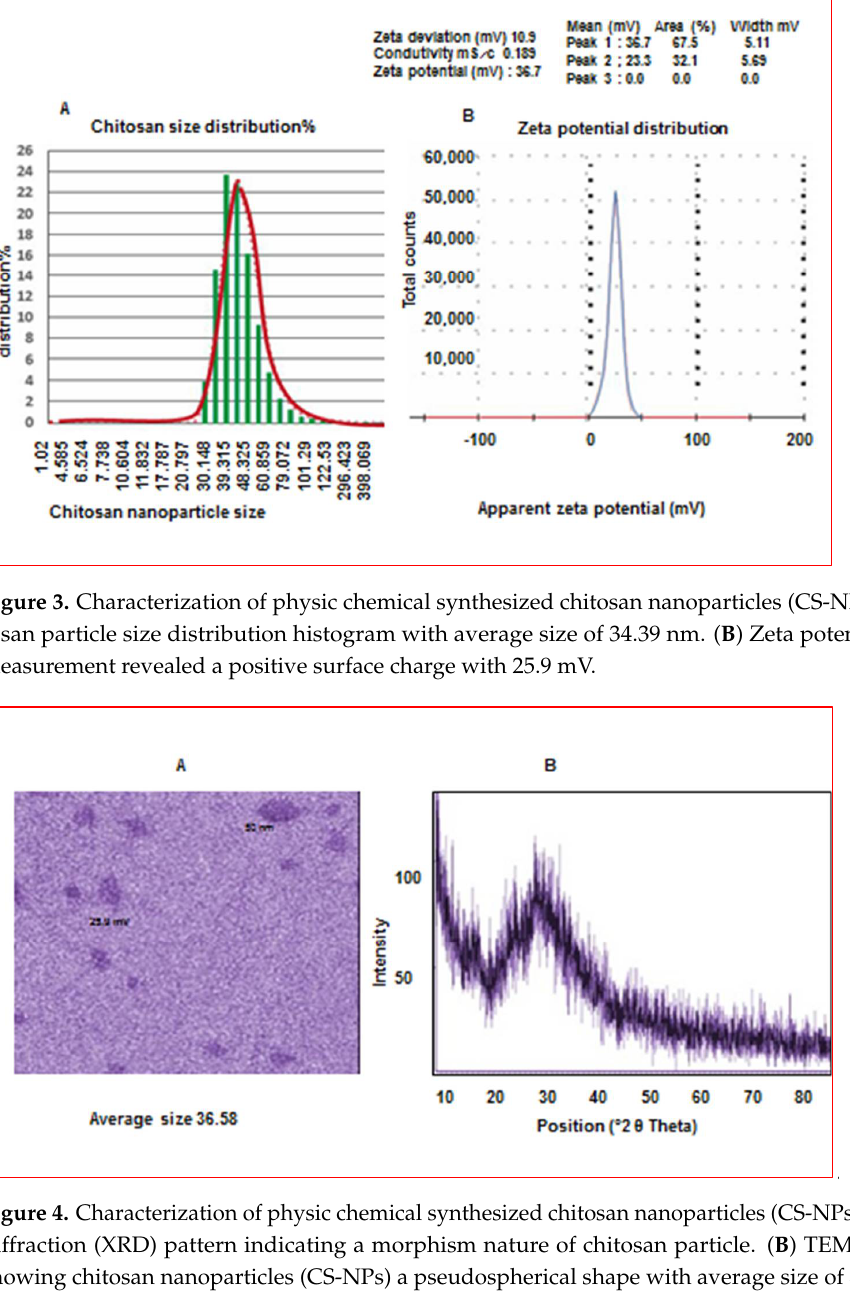
sprouts, shoot growth was determined by estimating the average of 10 shoot length measurements in cm, and the shoot growth was slow as compared to untreated cultures.